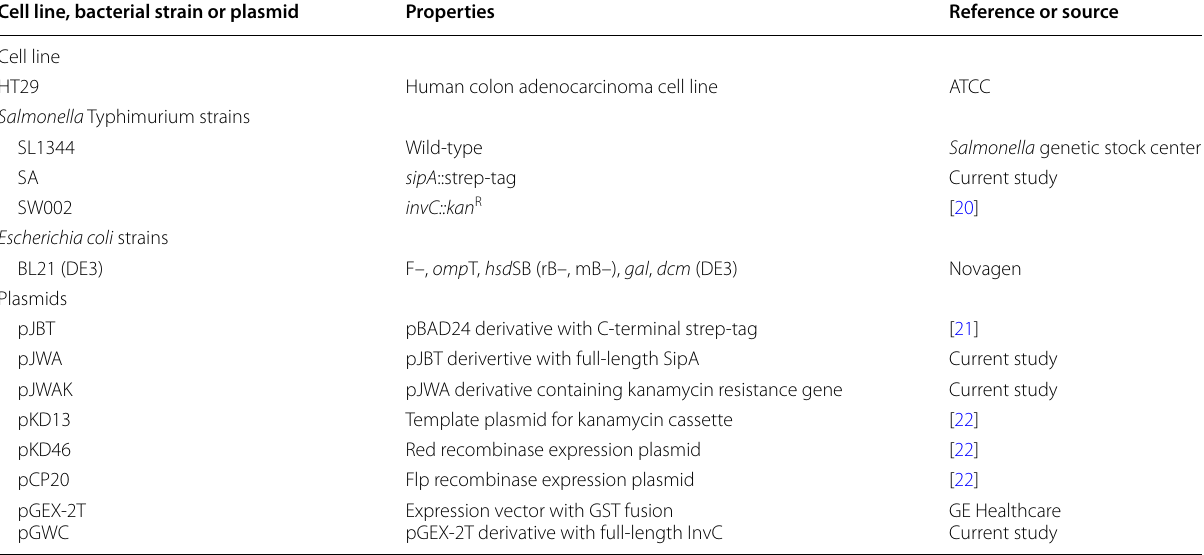
Table 1 Cell line, bacterial strains, and plasmids used in this study Cell line, bacterial strain or